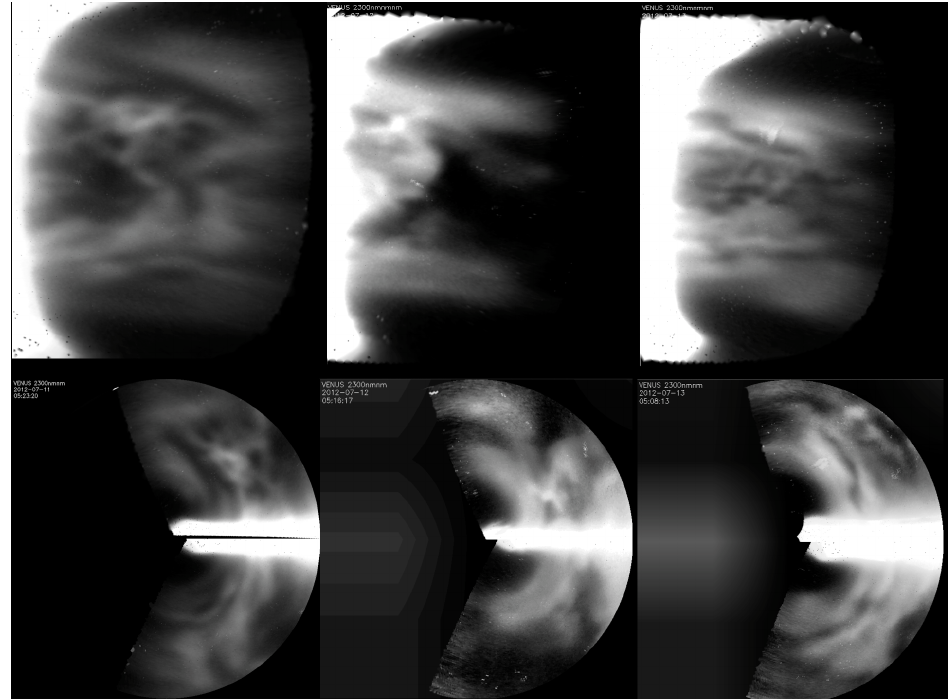
Figure 7. The upper row presents the cylindrical projections of nightside images in the mid-latitude region of Venus. These images show the bottom cloud level ( ∼ 48 km of altitude) and were obtained with a TNG/NICS camera, in the near-infrared domain at a wavelength of 2.28 µ m (from left to right: 11–13 July 2012). On the bottom row we present polar projections for the high latitude region around the north pole of Venus (again, from left to right: 11–13 July 2012). We note that white zones in the image are related to thinner clouds and darker regions imply a zone with thicker